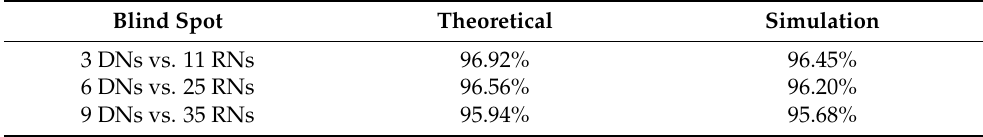
Table 6. PDR comparison for simulation environment and theoretical